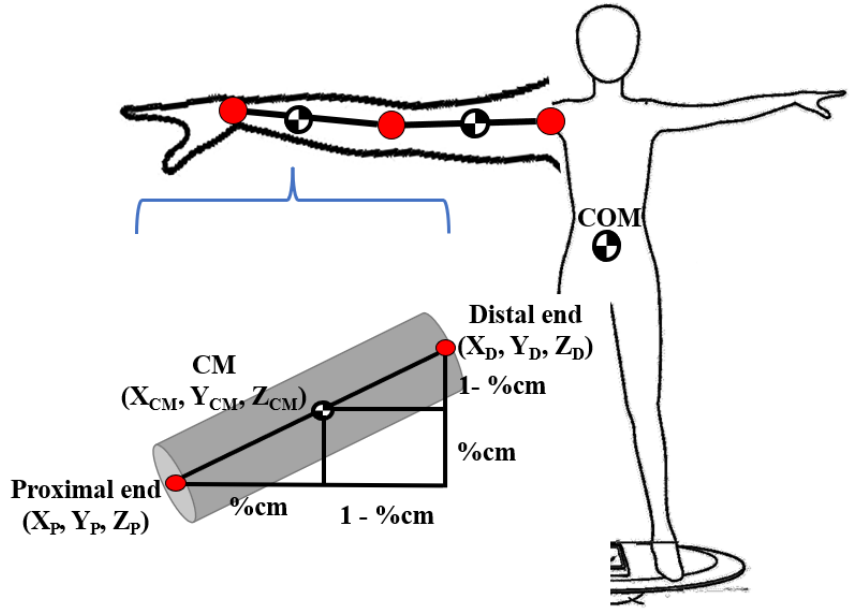
Figure 2. An example of detected key points as variables in a segmented part (arm), in order to explain how to calculate the location of the center of mass